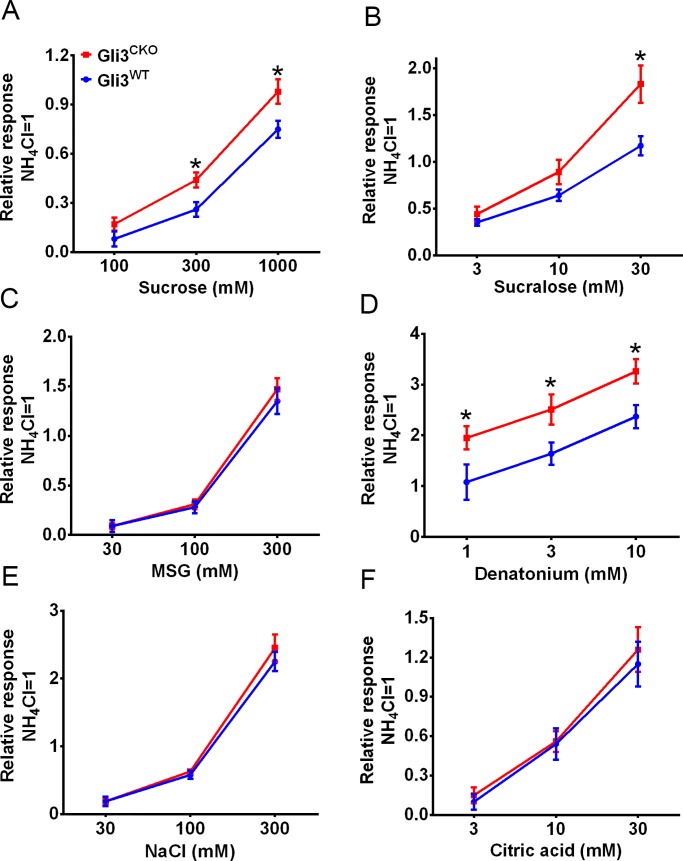
Increased taste nerve responses to sweet and bitter stimuli in Gli3CKO mice.Average glossopharyngeal (GL) nerve responses to sweet (sucrose and sucralose, A and B), umami (monosodium glutamate [MSG], C), bitter (denatonium, D), salty (NaCl, E), and sour (citric acid, F) tasting compounds are shown. The magnitude of the responses to taste compounds was normalized against the response to 100 mM NH4Cl. Compared to Gli3WT mice, Gli3CKO mice exhibit increased nerve responses to sucrose, sucralose, and denatonium across a range of concentrations, while the responses to other stimuli were unaffected. Statistically significant differences were determined by repeated two-way ANOVA test [sucrose: F (1, 63) = 12.32, P<0.05; sucralose: F (1, 78) = 9.67, P<0.05; MSG: F (1, 71) = 0.71, P>0.05; denatonium: F (1, 68) = 14.81, P<0.05; NaCl: F (1, 67) = 0.36, P>0.05; citric acid: F(1, 72) = 1.51, P>0.05] and post hoc t-test (n≥7, *p<0.01). All data are presented as the means±SEM.